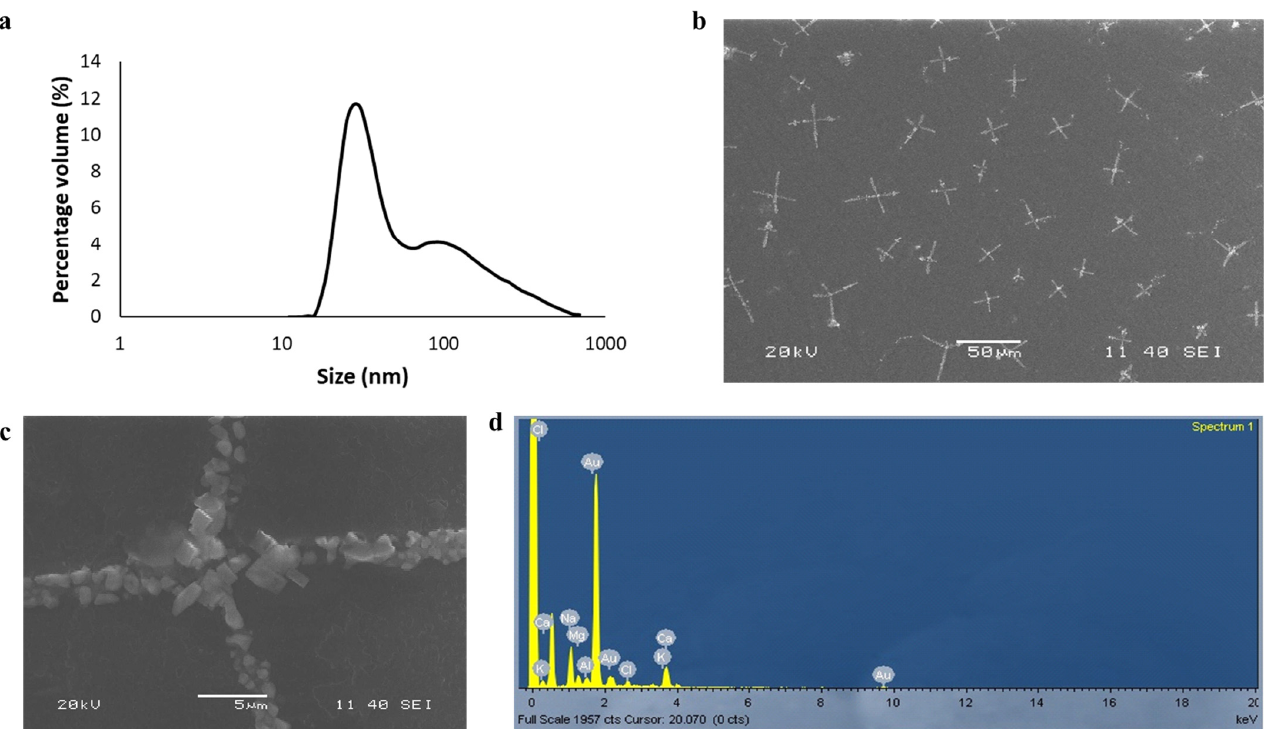
Figure 1. ( a ) The dynamic light scattering experiment showed that particles were mostly monodis- persed (polydispersity index = 0.28). A majority of the number of nanoparticles was found to be less than 100 nm. ( b ) Cruciform assembly of gold nanoparticles synthesized from Cannabis indica leaf water extract method. ( c ) A magnified image of the cruciform assembly. ( d ) EDX analysis of the sample confirmed the presence of gold.